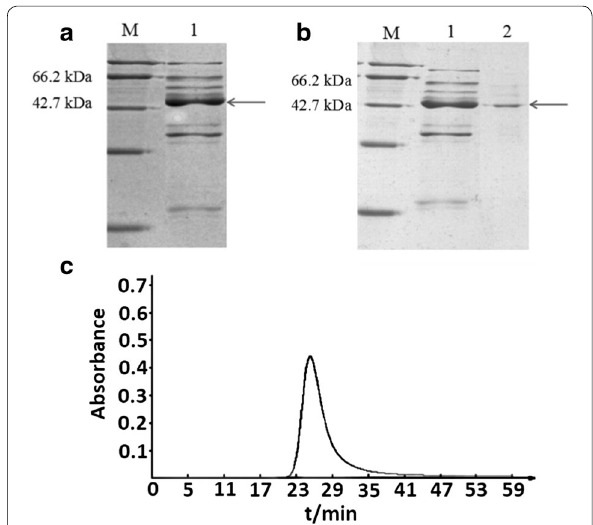
Fig. 3 Extraction and purification of slpA protein from Lactobacillus